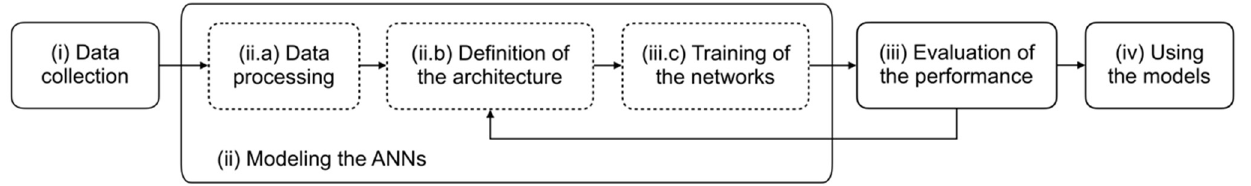
Figure 1. Schematic representation of the proposed workflow.